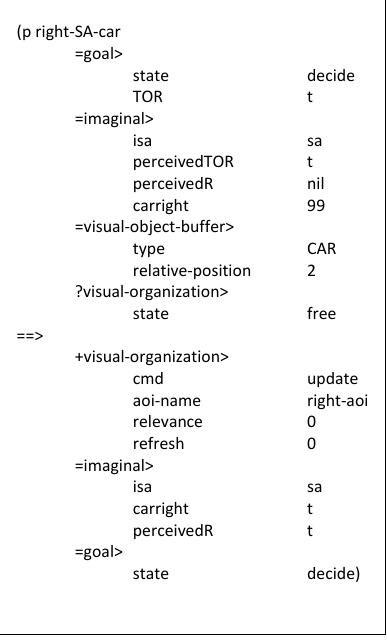
Figure 3. Exemplary production rule that fires when a car on the right oncoming lane is perceived while situation awareness is build up (99 = dummy variable; t = true; TOR = takeover request; R = right; aoi = area of interest; sa = situation awareness; source: own